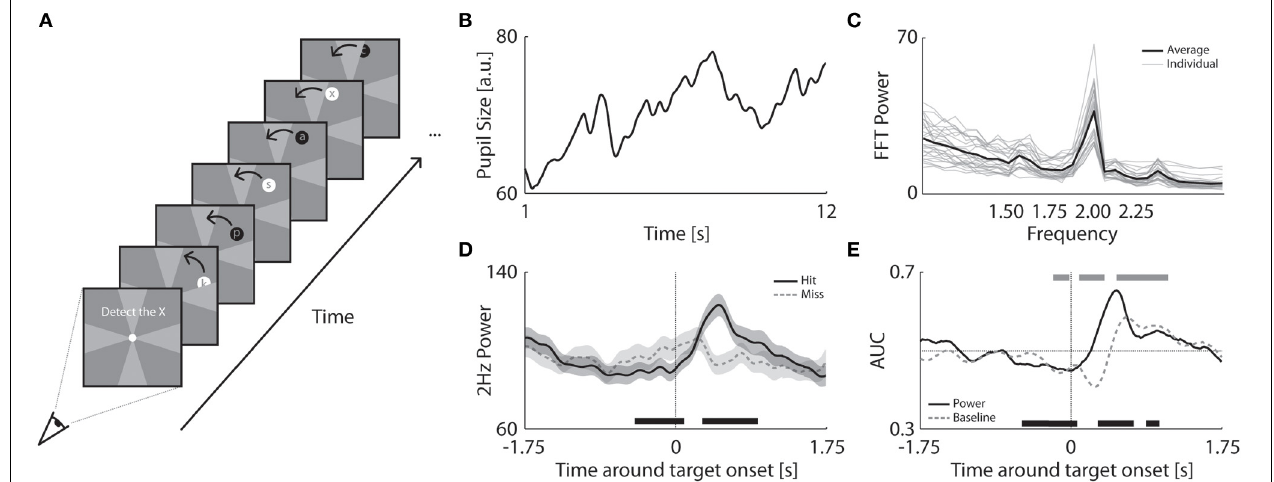
FIGURE 3 | Pupillary prediction of attentional resources and behavioral performance. (A) Procedure of Experiment 3 in which a flickering disk (2Hz) with a superimposed letter stream circled around fixation. Observers had to detect the “ x ” while fixating at the center dot. The disk moved behind occluders at the vertical and horizontal meridians. The occluders had the same color as the background but are here indicated in a brighter gray for clarification. (B) Example of an observer’s pupil size trace in a single trial. (C) FFT power analysis per observer ( gray ) and averaged across observers